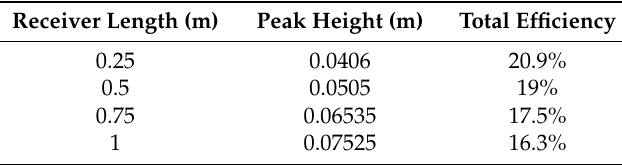
Table 3. Receiver height comparison at different lengths.